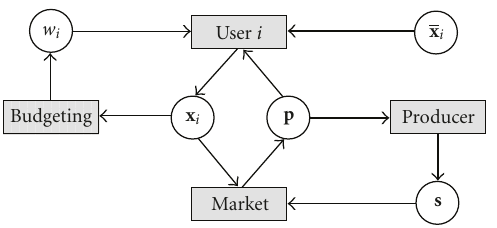
Figure 1: Interaction among four types of agents in the proposed competitive spectrum